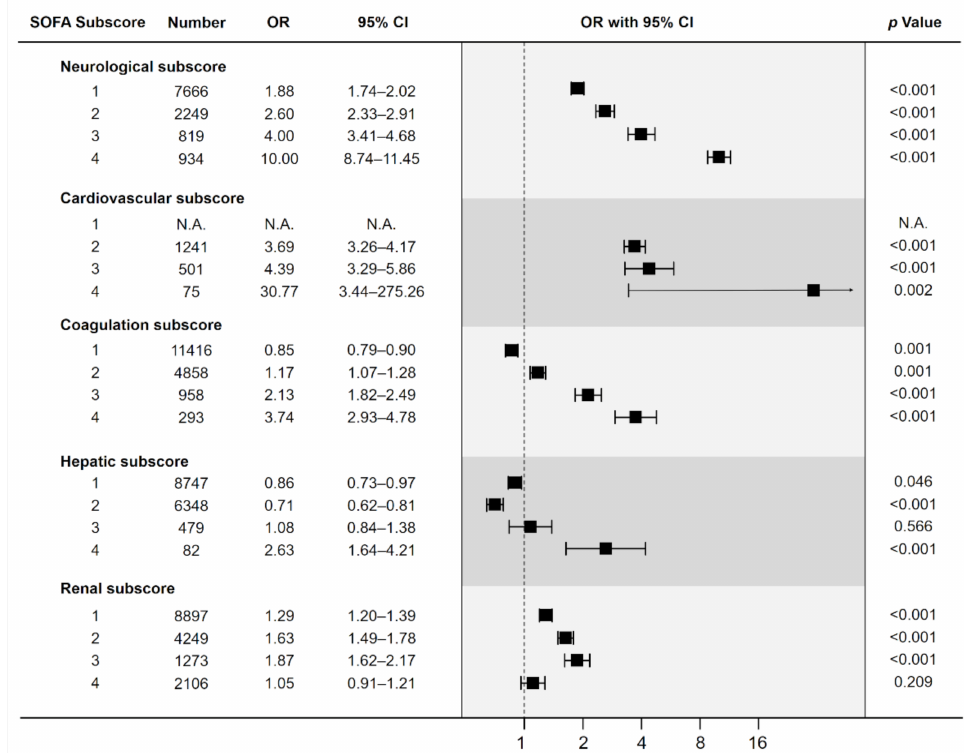
Figure 3. Mortality odds ratios according to the increase in SOFA subscores, compared to 0 points for each subscore. CI: Confidence Interval, OR: Odds Ratio, SOFA: Sequential Organ Failure Assessment, N.A.: Not